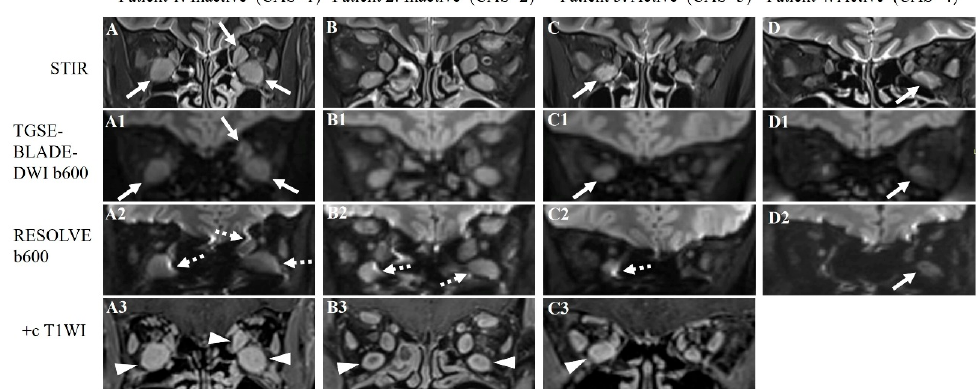
Figure 2. Representative STIR ( A – D ), TGSE-BLADE-DWI b600 ( A1 – D1 ), and RESOLVE b600 images ( A2 – D2 ) of four TAO patients with different clinical activity scores (CAS). Patient 1 was a 43-year-old male TAO patient with CAS = 1, with bilateral enlarged inferior and left medial rectus muscles shown on the STIR sequence ( A ) that could be clearly displayed on TGSE-BLADE-DWI (white arrows in A1 ); slight to moderate susceptibility artifacts and geometric distortions were seen with RESOLVE (dotted arrows in A2 ). Patient 2 was a 45-year-old male TAO patient with CAS = 2; the bilateral superior, inferior, and medial rectus muscles were enlarged in size and were clearly visualized without artifacts on TGSE-BLADE-DWI ( B1 ); the bilateral inferior rectus muscles were slightly distorted on RESOLVE (dotted arrows in B2 ). Patient 3 was a 42-year-old female TAO patient with CAS = 3; the right inferior rectus was enlarged on STIR ( C ) and is clearly shown on TGSE-BLADE-DWI (white arrow in C1 ) but was severely affected by susceptibility artifacts and geometric distortions on RESOLVE (dotted arrow in C2 ). Patient 4 was a 55-year-old female TAO patient with CAS = 4; the left inferior rectus was enlarged on STIR and was displayed well both in TGSE-BLADE-DWI and RESOLVE (white arrows in D1 , D2 ). Contrast-enhanced T1WI (+c T1WI) scans ( A3 – C3 ) were performed in patient 1–3, and the coronal images identified the enlargement of multiple EOMs (arrowheads in A3 , B3 and C3